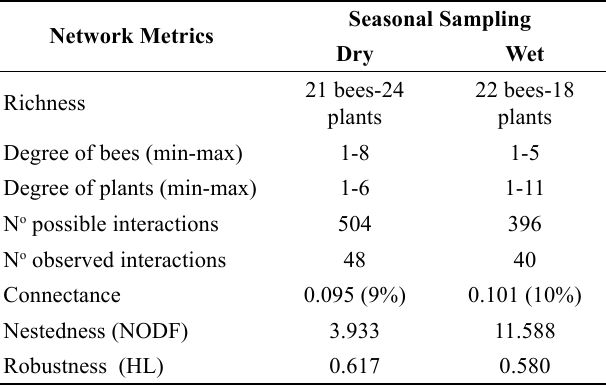
Table 3 . Metrics of interaction networks between bees and plants in the dry and wet seasons at Itaoca Inselberg in the Atlantic Forest in southeastern Brazil.